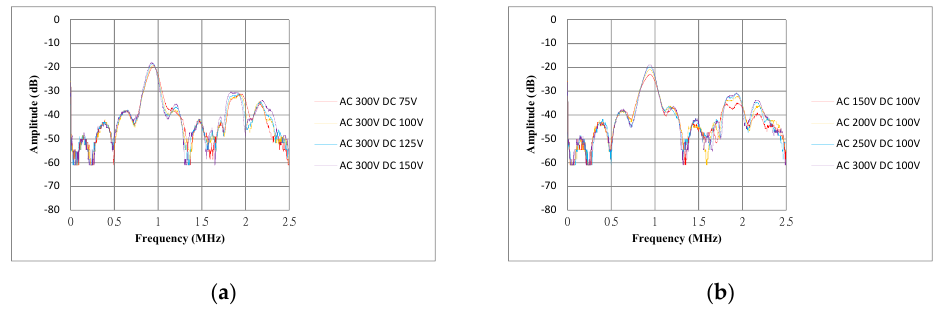
Figure 17. ( a ) Spectra of received signals of the transparent CMUT under AC 300 V and various DC bias voltage; ( b ) Spectra of received signals of the transparent CMUT under DC 100 V and various AC pulse voltage.